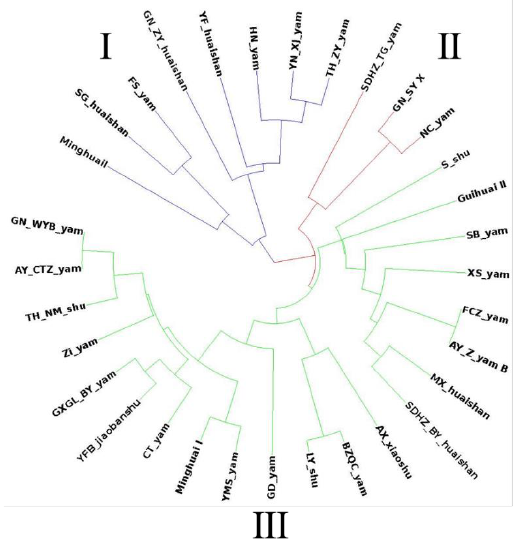
Figure 4. Phylogenetic tree of 32 Chinese yam germplasms. purple lines: Clade I; red lines: Clade II; green lines: Clade III.